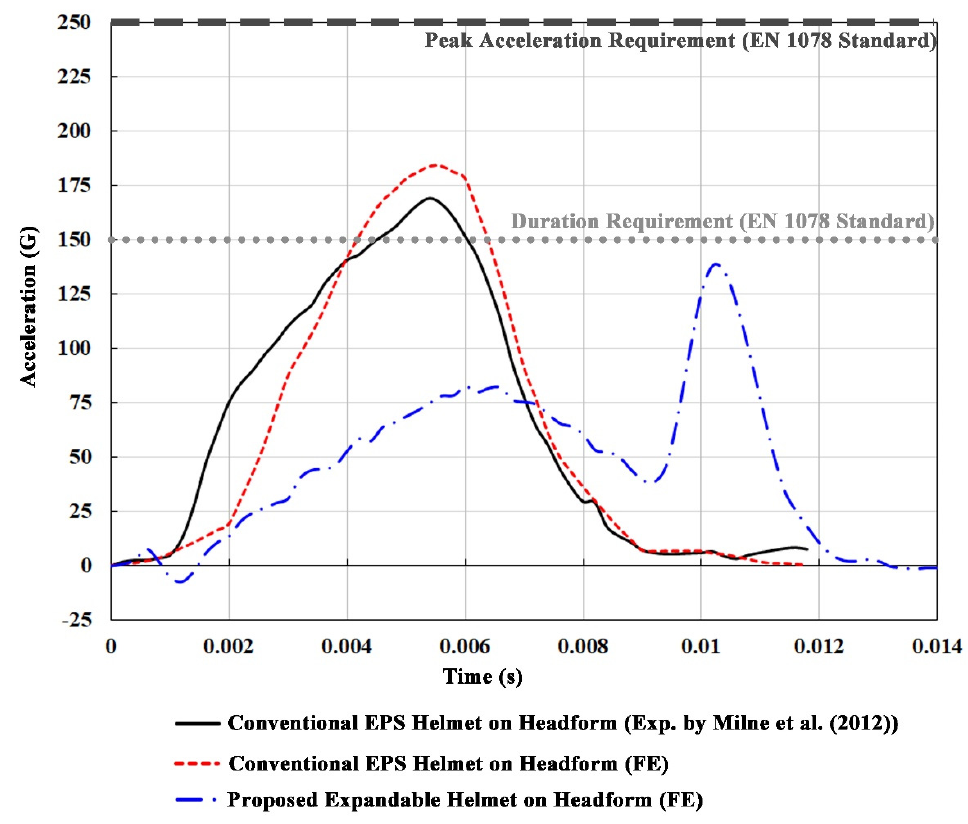
Figure 2. Experimental and simulated accelerations at the CG of the headform equipped with the EPS control helmet and the novel airbag helmet.